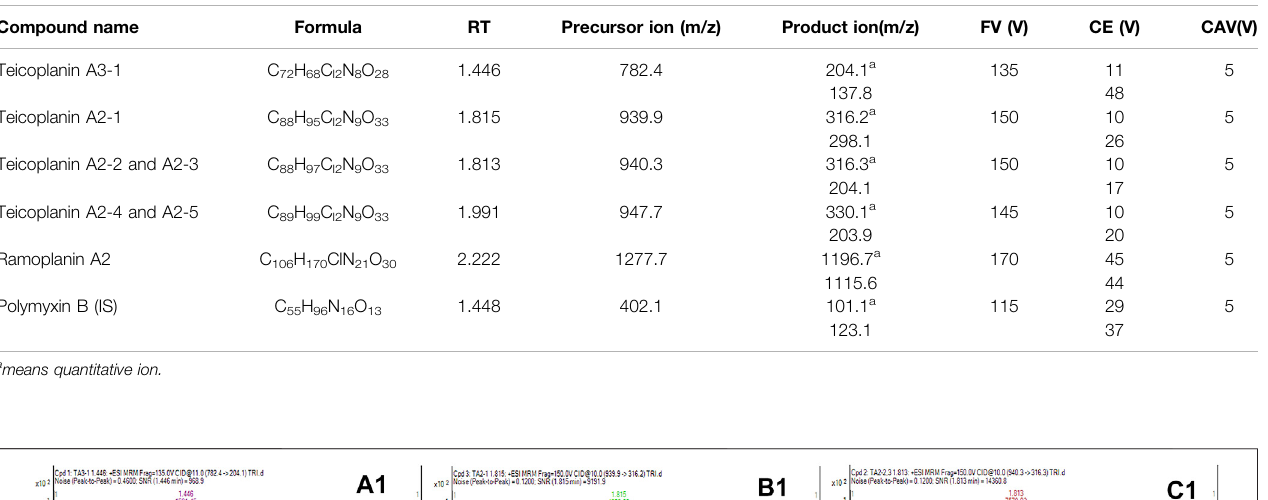
TABLE 1 | MRM parameters of all target peaks and the internal standard.